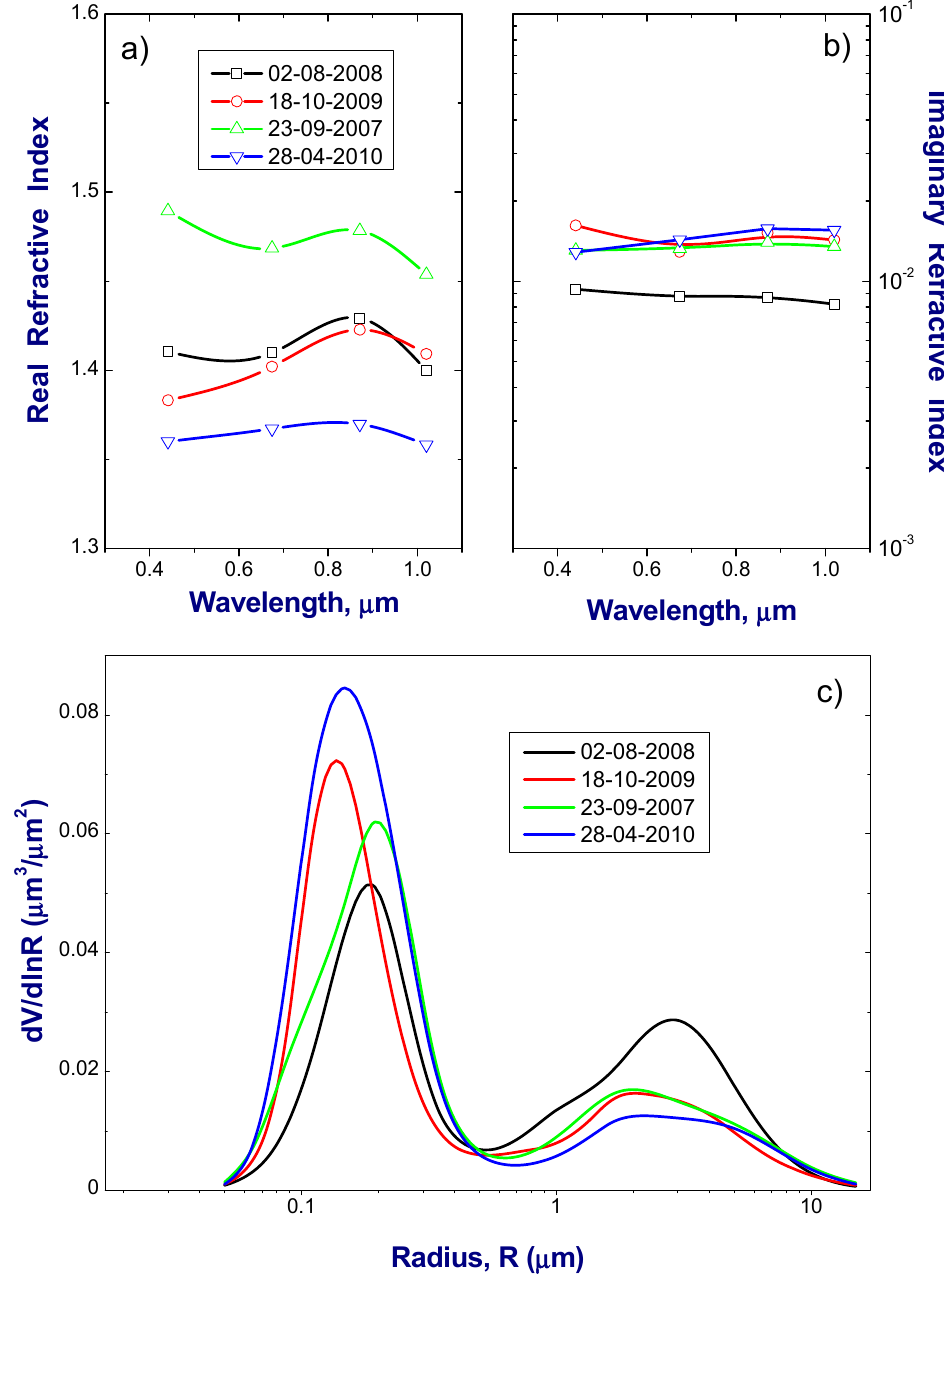
Figure 2. The real ( a ) and imaginary ( b ) parts of the complex reflective index and volume size distribution ( c ) from the AERONET aerosol retrieval for the selected four days. These aerosol microphysical properties are considered as “true” microphysical properties in our sensitivity